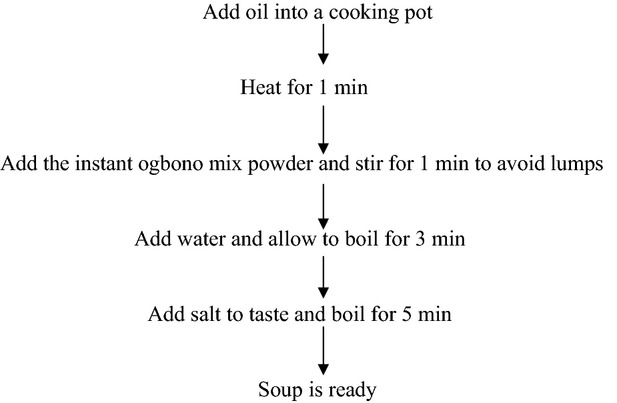
Flow chart for the preparation of ogbono soup.